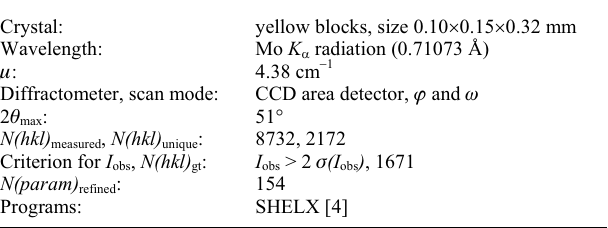
Table 1. Data collection and handling.